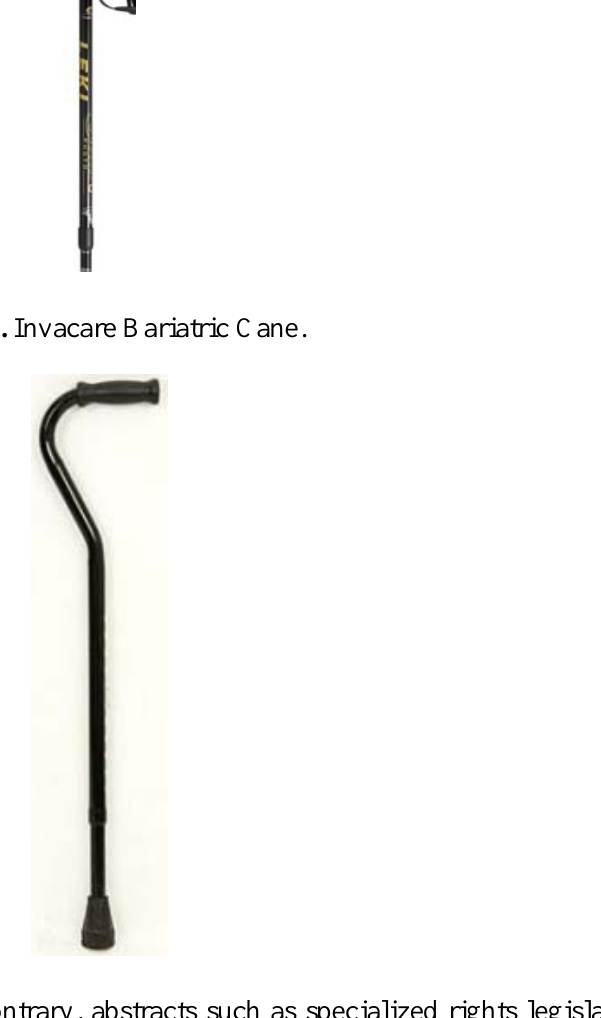
Figure 1. Leiki Walking Staff.